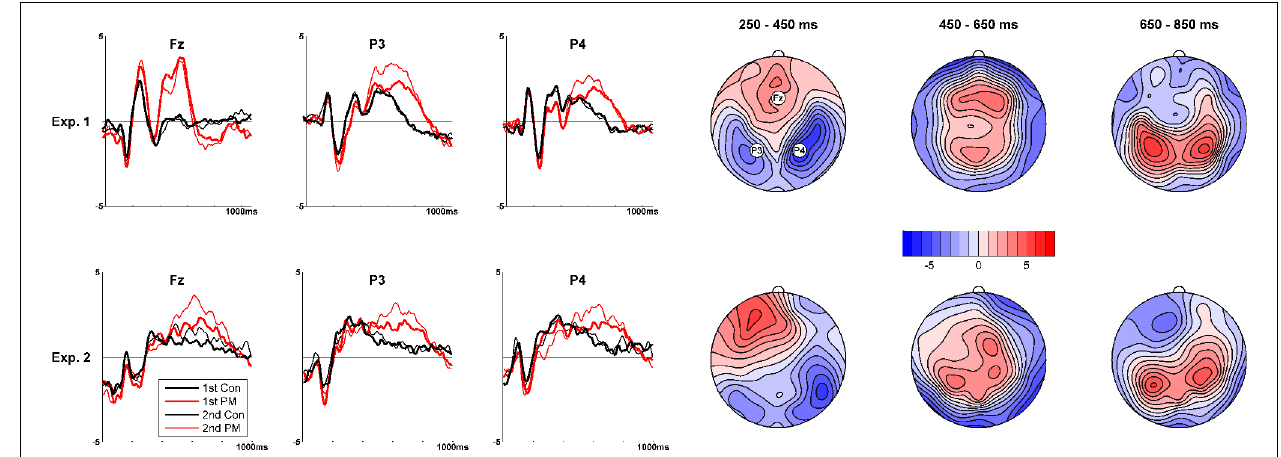
FIGURE 1 | Prospective memory components for Experiment 1 and Experiment 2. Left: ERPs for prospective memory targets (PM; red lines) and control trials (Con; black lines) at selected electrodes, for first (1st) and second half (2nd), respectively. Right: t -maps comparing the ERPs from the